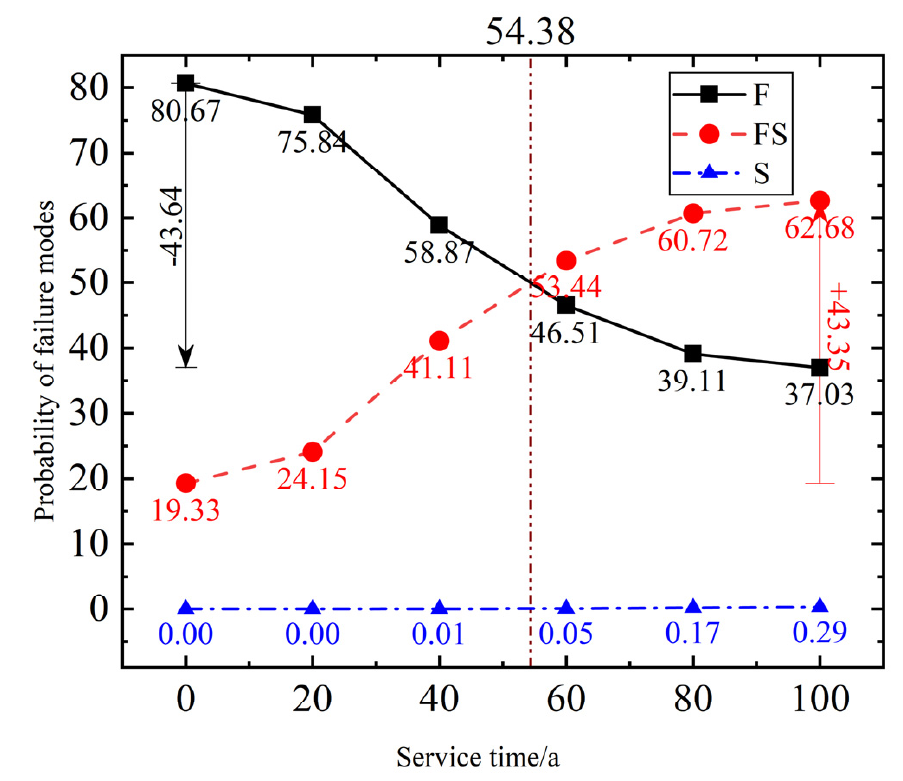
Figure 10. Variation in failure modes of bridge piers during service.